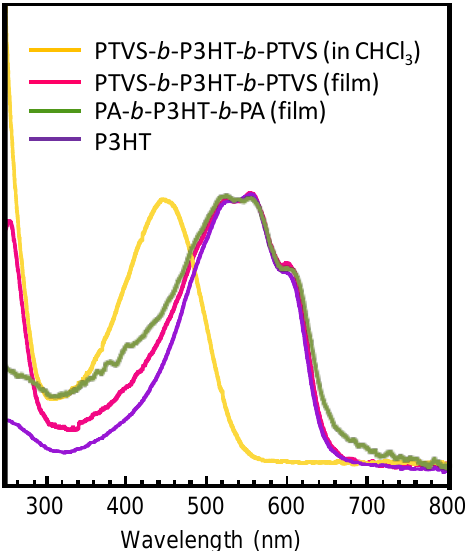
Figure 6. UV-vis spectra of PTVS- b -P3HT- b -PTVS in chloroform (yellow line), PTVS- b -P3HT- b -PTVS film (yellow line), PA- b -P3HT- b -PA (green line), and P3HT film (purple line).